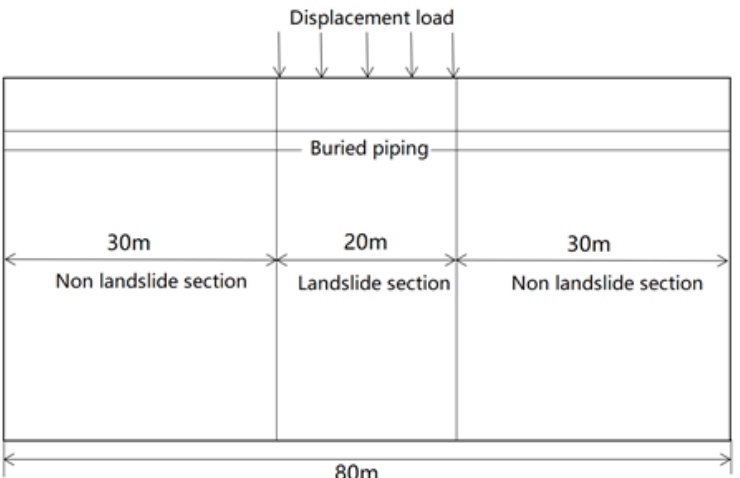
Figure 2. Schematic illustration of soil model.